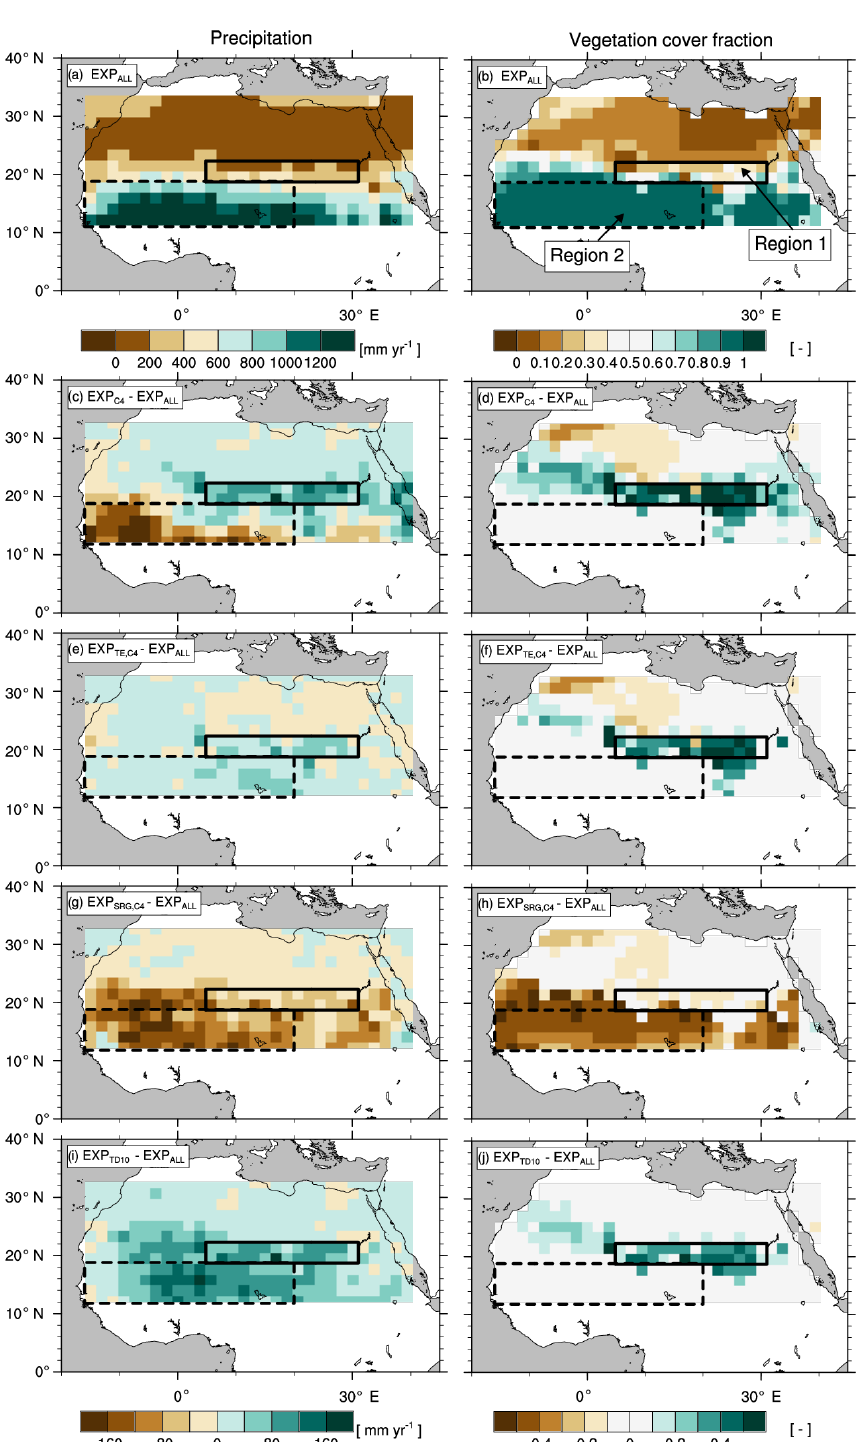
Figure 2. Effects of changes in plant functional diversity on precipitation P (left column) and vegetation cover fraction veg max (right column) during the AHP (8kyr) in Region 1 (18.65 to 22.38 ◦ N, 4.69 to 30.94 ◦ E; solid box) and Region 2 (11.19 to 18.65 ◦ N, 15.94 ◦ W to 19.69 ◦ E; dashed box). Panels (a, b) show 100-year averages for the experiment with the standard PFT set (EXP ALL ). The following panels illustrate differences in 100-year averages between EXP ALL and EXP C